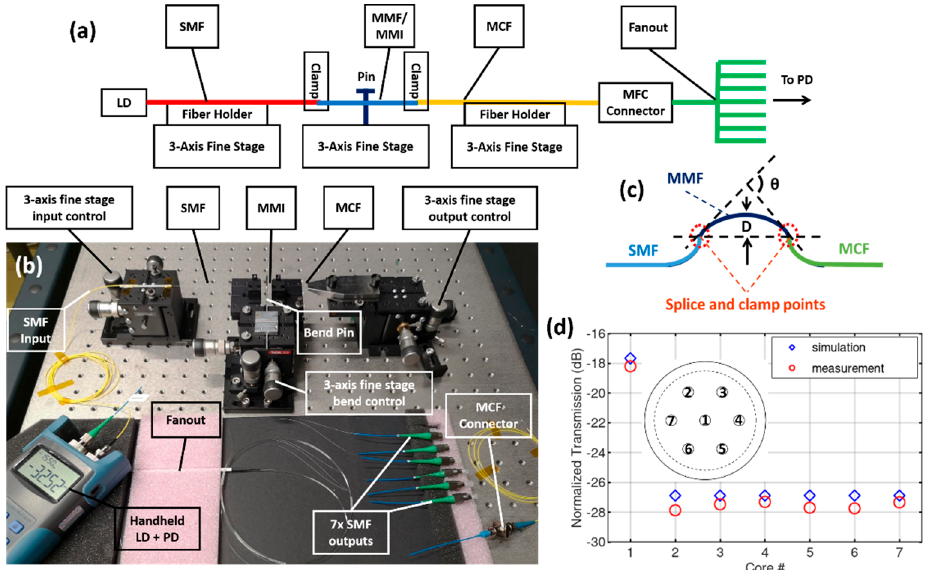
Figure 4. ( a ) Schematic layout and ( b ) photo of the experiment setup. ( c ) Mounting layout for the bent MMF/MMI. ( d ) Simulated and measured power distribution among the 7 output SMFs for the unbent case .